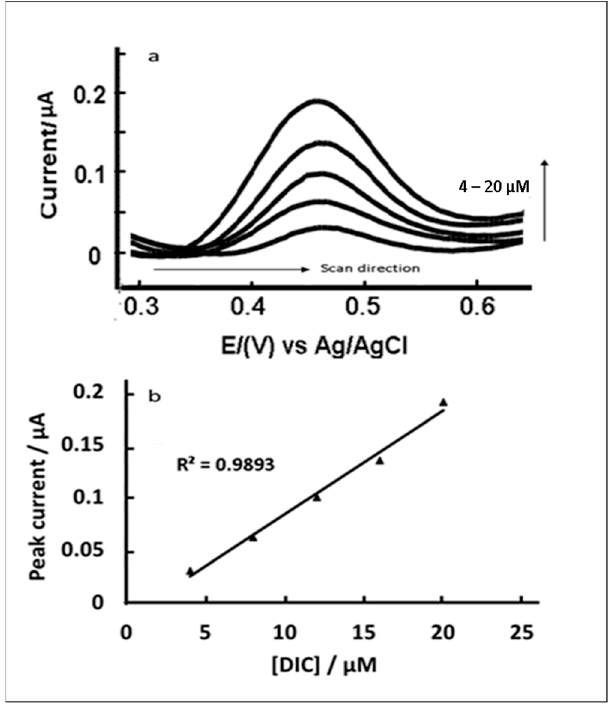
Figure 7. DPV (background subtracted) of increasing dibucaine concentrations (4, 8,12, 16 and 20 µM) in artificial serum (BSA absence) at the microinterface array ( a ). Calibration curve of peak currents vs. concentrations ( b ).